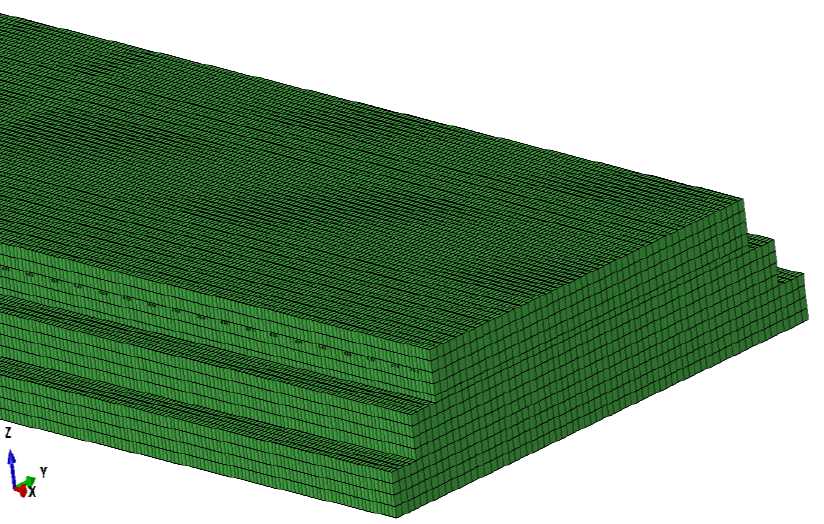
Figure 9. Grid diagram of the ballastless track.